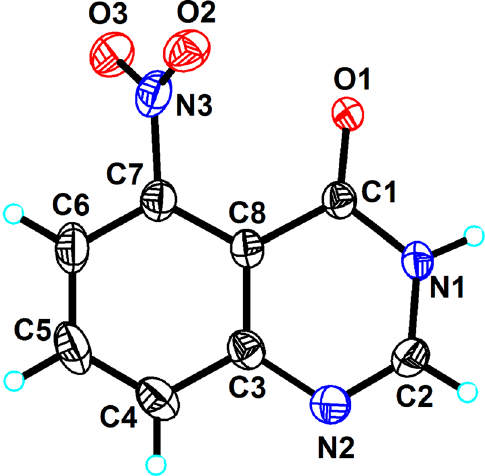
Table  : Fractional atomic coordinates and isotropic or equivalent isotropic displacement parameters (Å 